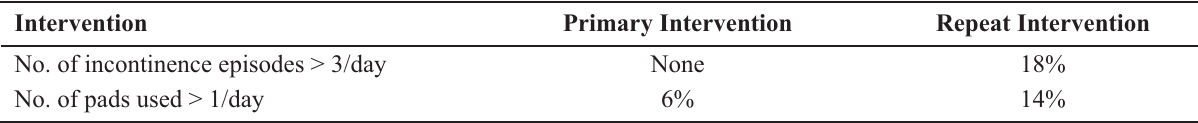
Table 4 – Outcome after primary versus repeat intervention.